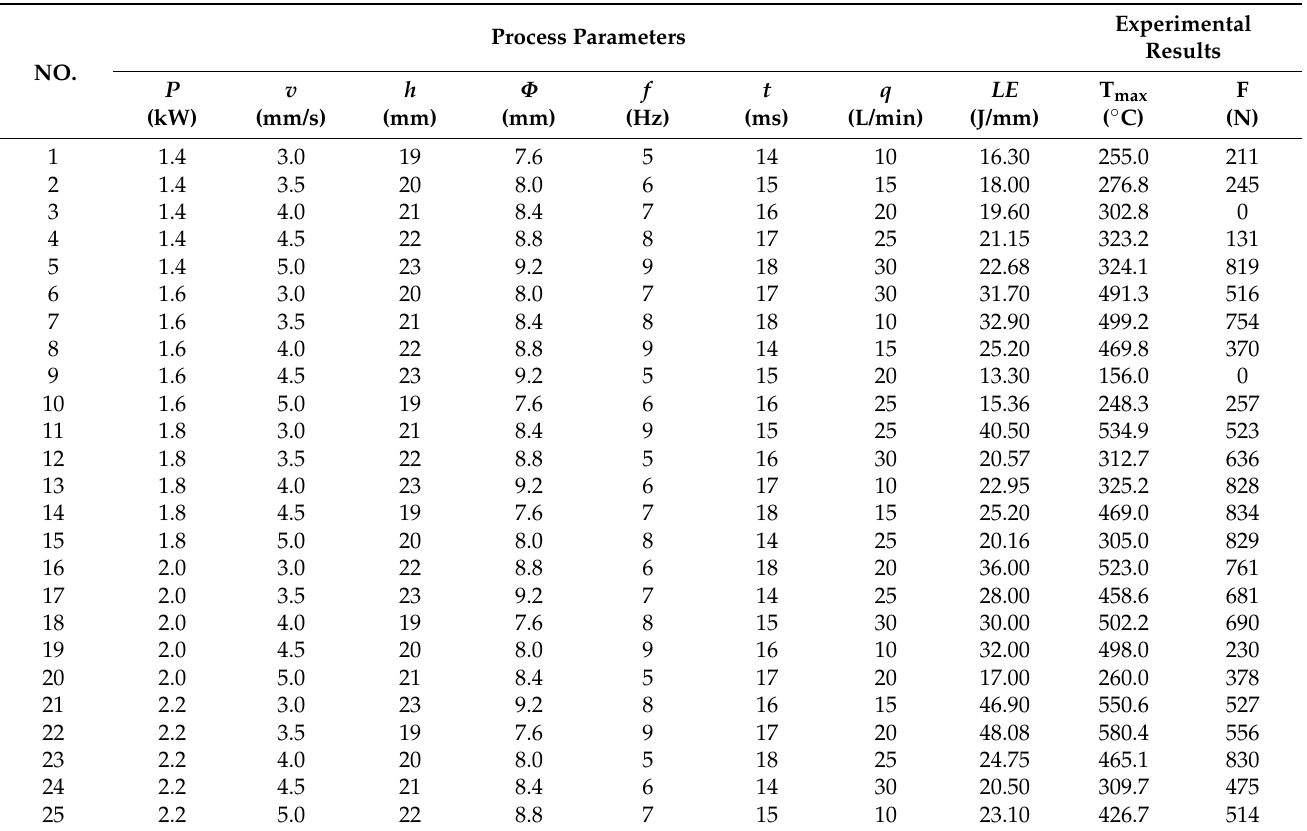
Table 3. Line energy and maximum temperature for each process parameter combination in the L 25 orthogonal experimen- tal